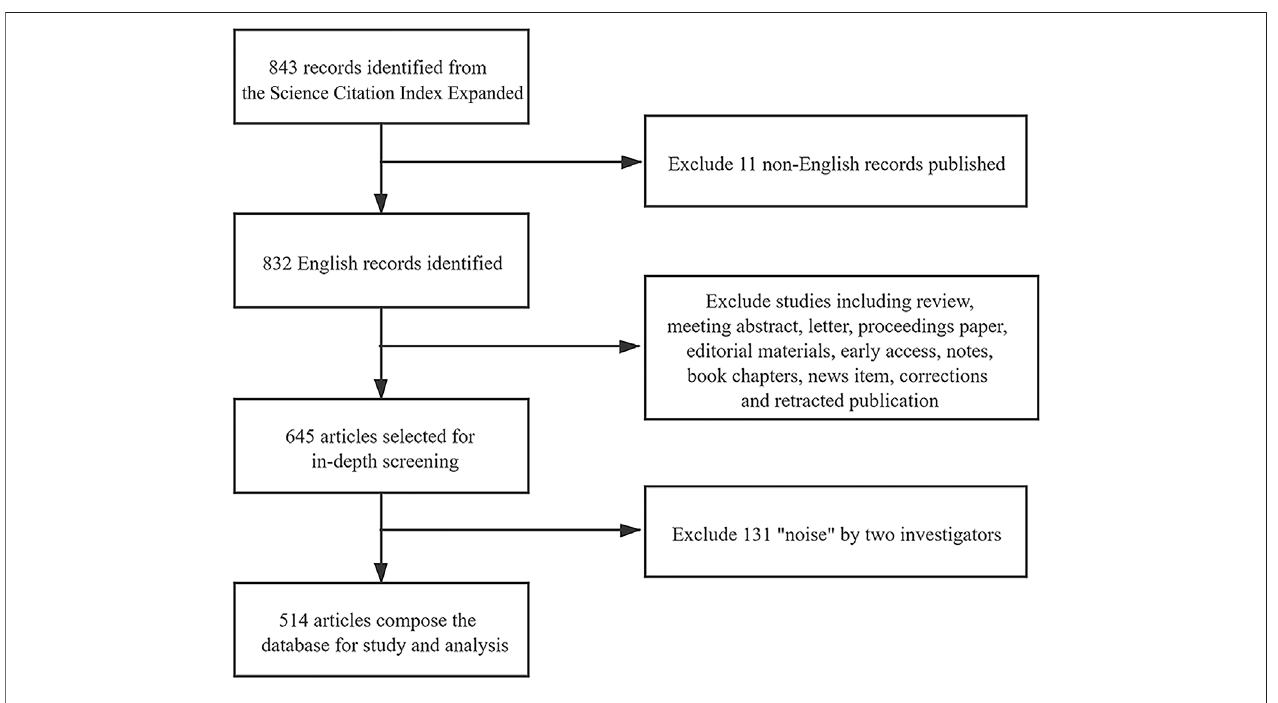
FIGURE 1 | The fl ow chart of database